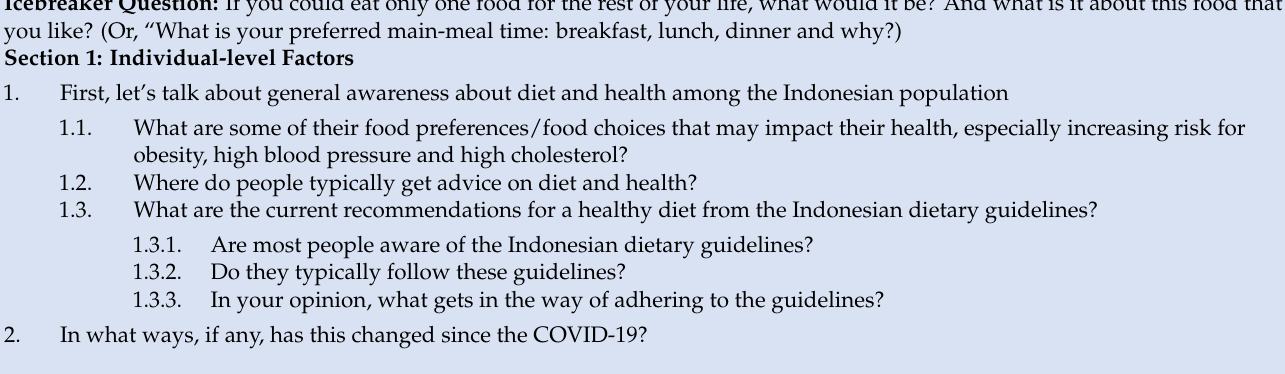
Table 2. COVID-19 Related Questions for Study